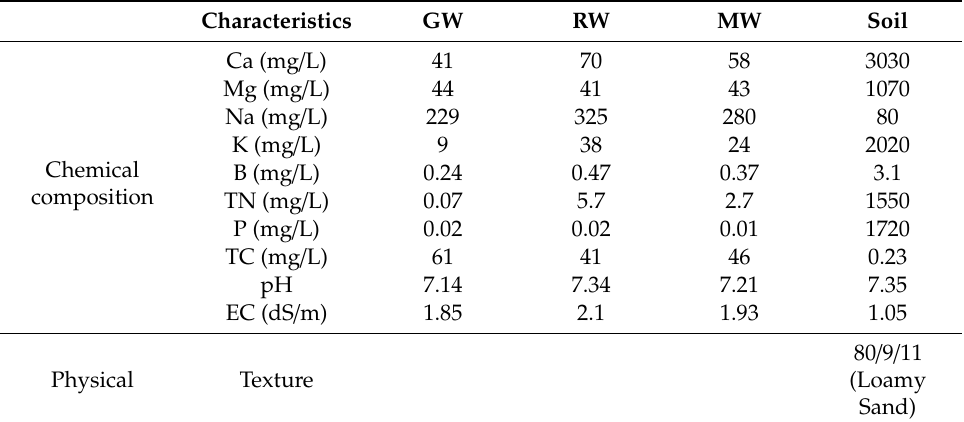
Table 1. Initial chemical and physical characteristics of experimental water and soil.